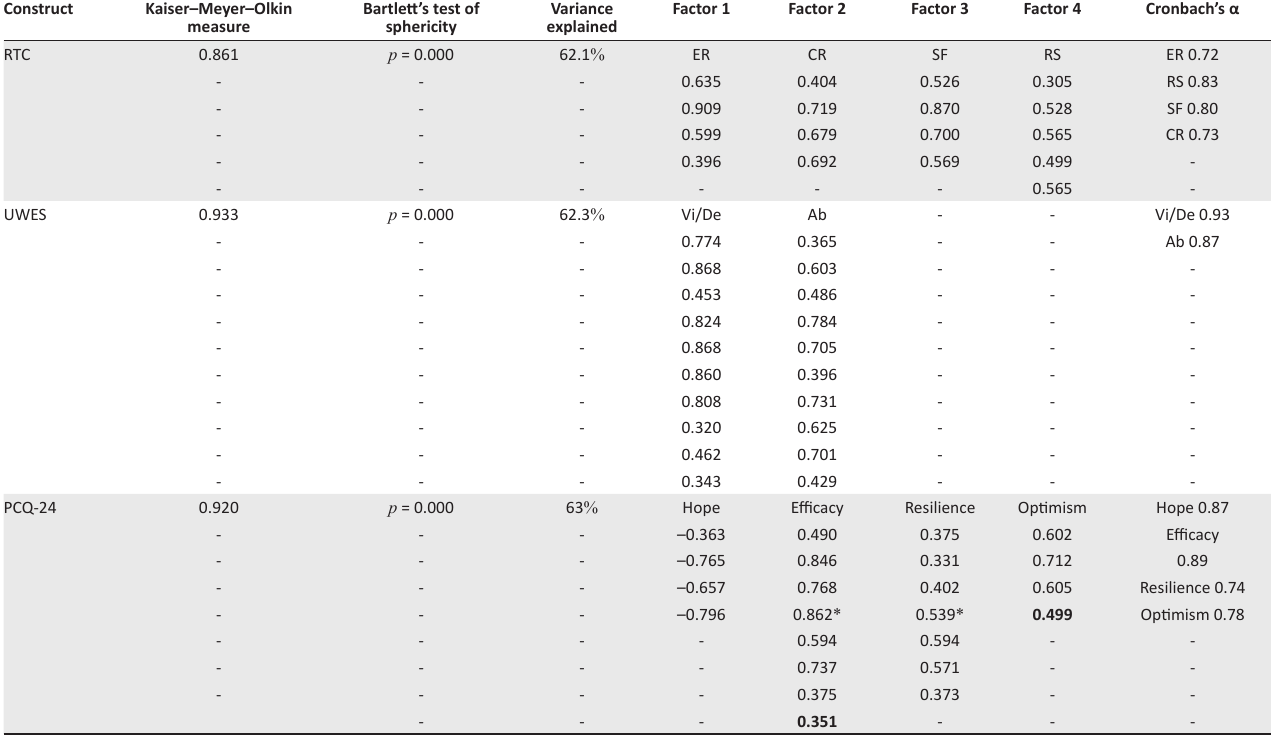
TABLE 1: Factor loadings and Cronbach’s α values for the resistance-to-change scale, Utrecht work engagement scale and psychological capital questionnaire-24. Construct Kaiser–Meyer–Olkin measure